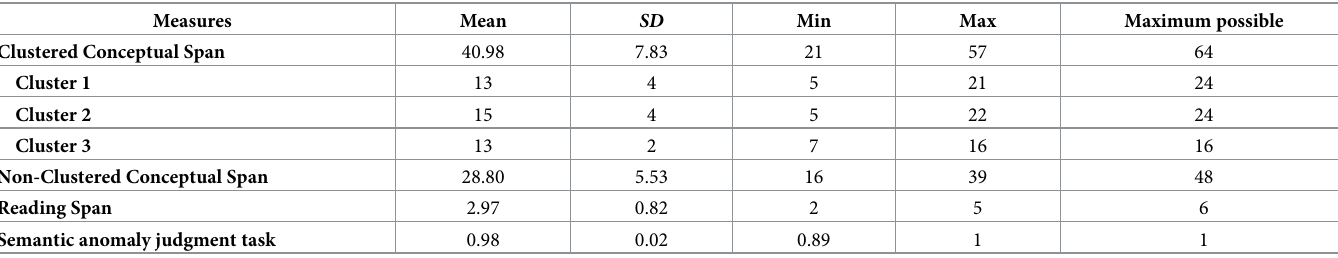
Table 3. Mean performance on the measures employed in Study